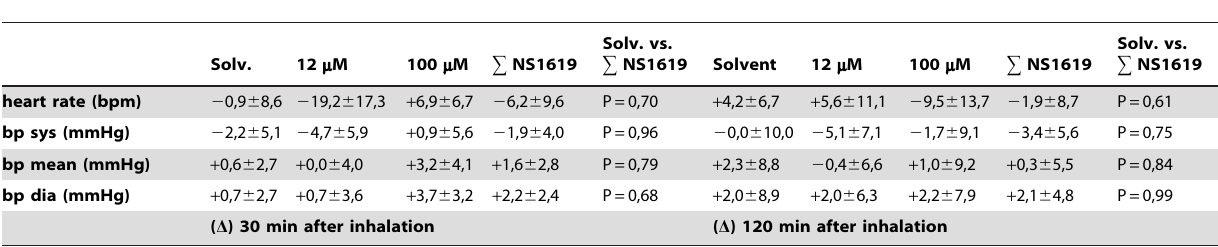
Table 2. Systemic hemodynamic parameters.